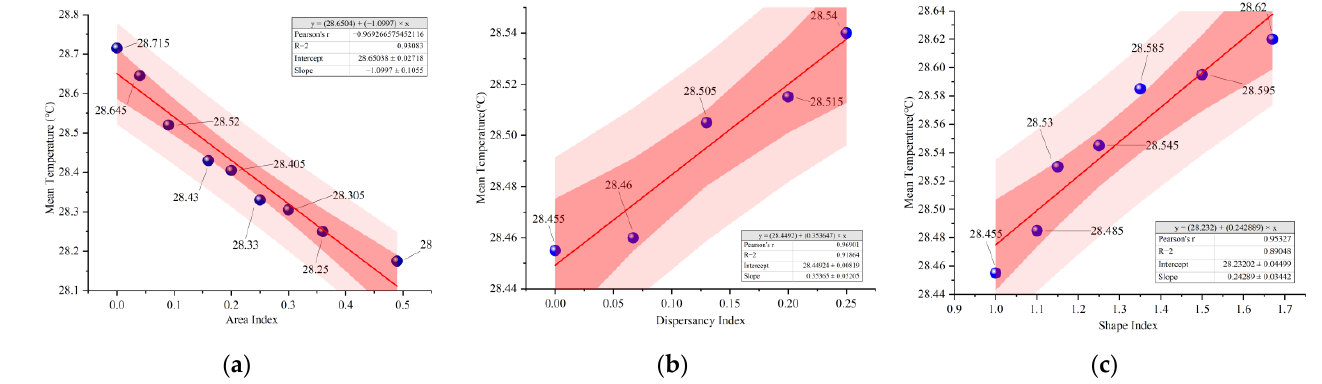
Figure 7. Correlation analysis of temperature and microclimate for different water layout factors: ( a ) Water body area index; ( b ) Water body dispersion index; ( c ) Water body shape index.